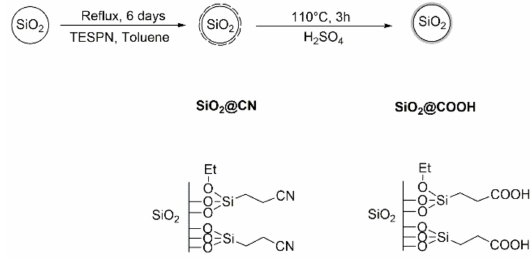
Figure 4. Synthetic pathway of the functionalized SiO 2